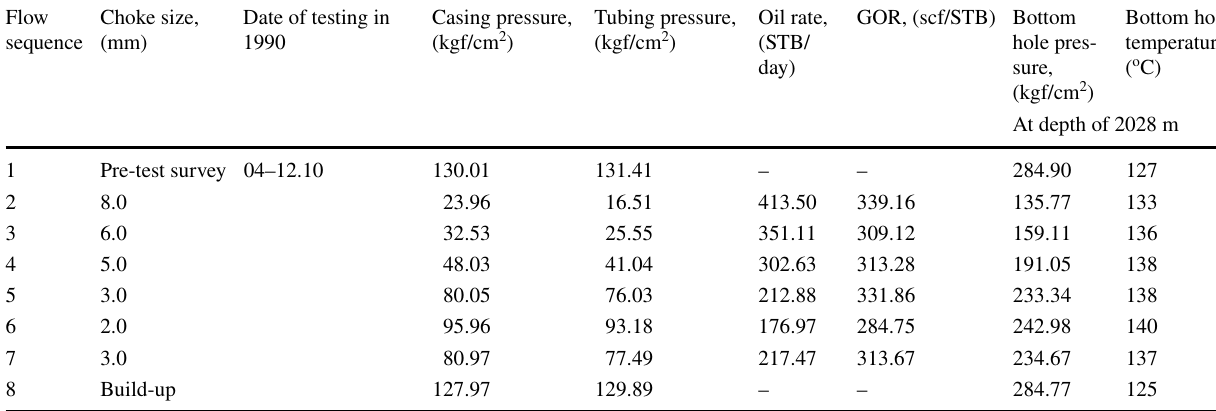
Table 13 Production test results of Well # 12 Vorobyevskaya